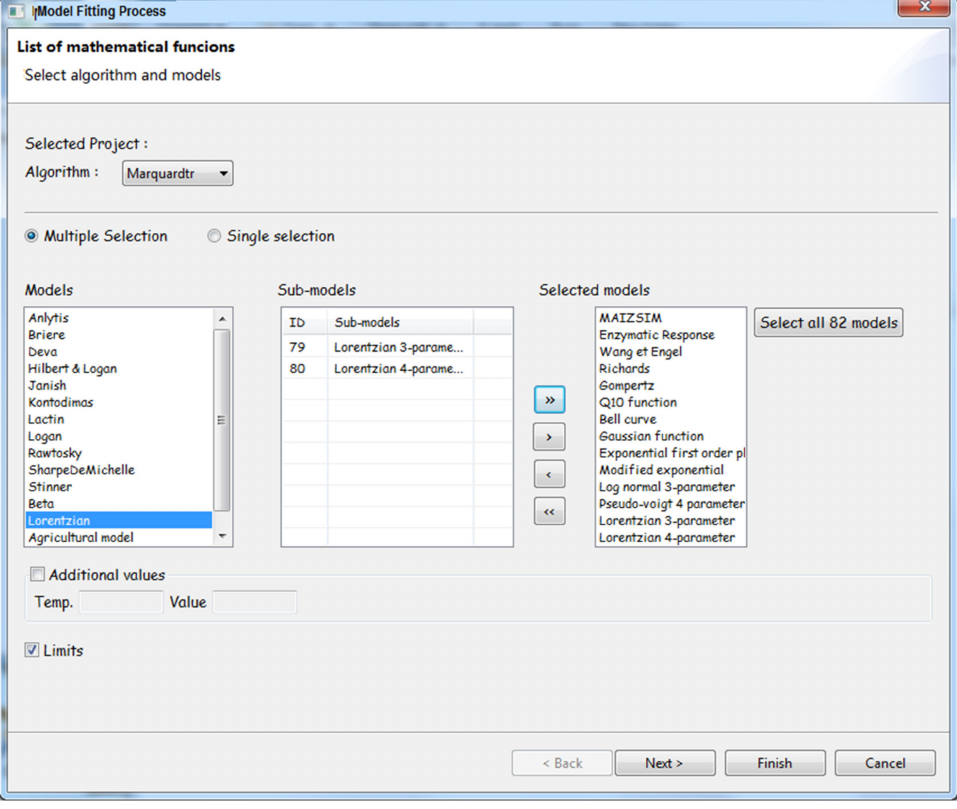
Figure 5. Wizard for the selection list for the fitting process. This frame assists the user in the selection of equations to be fitted with experimental